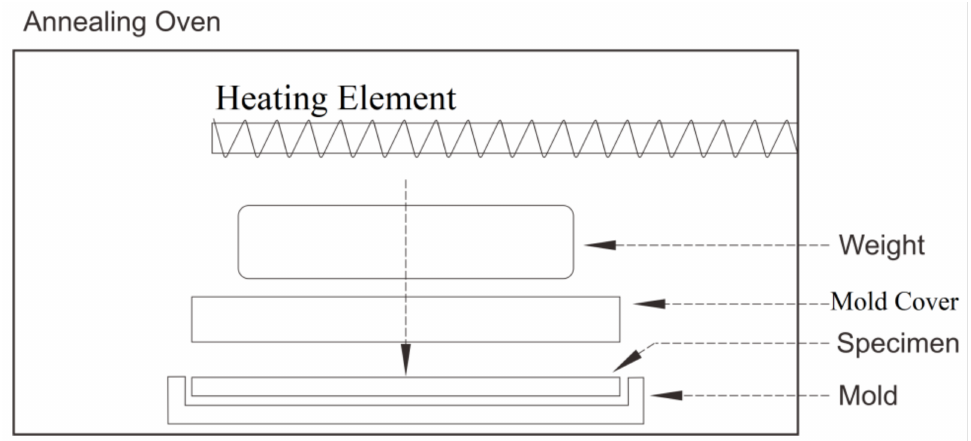
Figure 13. The experimental setup for pressure-assisted annealing of an FFF-processed polymeric